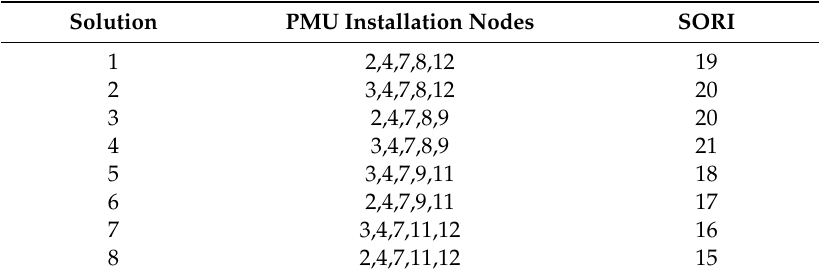
Table 4. PMU placement solutions for a 13-node test feeder considering ZIB e ff